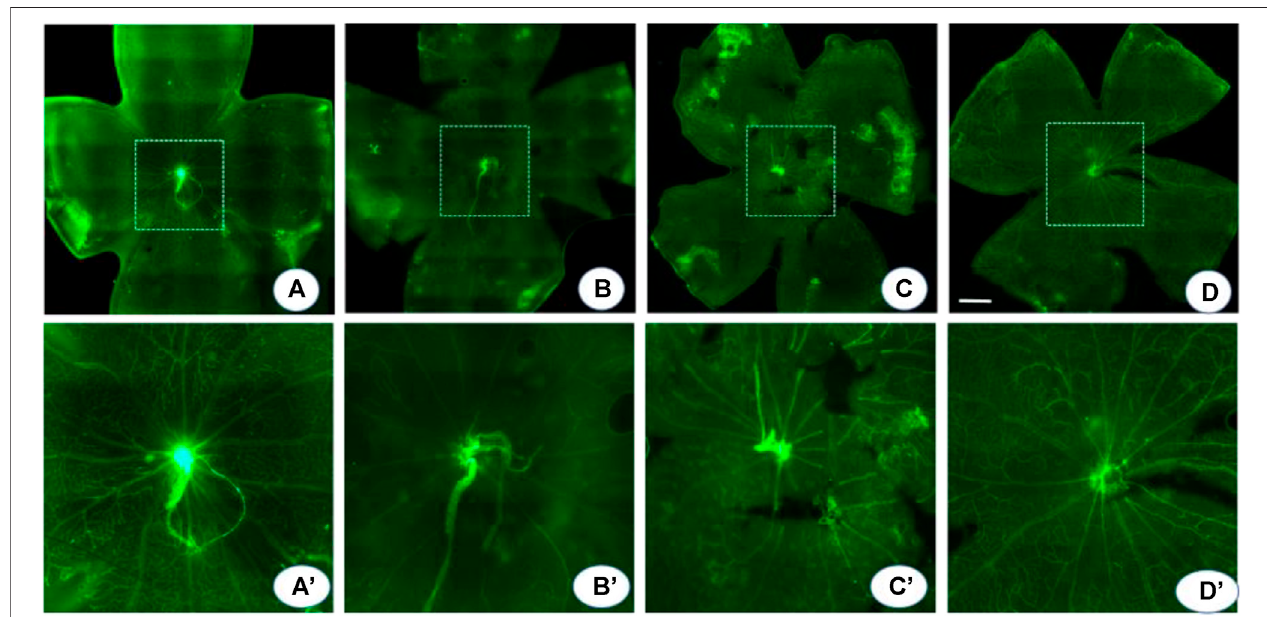
FIGURE4| Probeneciddecreasedcentralvaso-obliteration.Anisolectin fl uorescein – stainedretinal fl atmountwasusedtodetectthecentralvaso-obliteratedarea. (A) Inthenormoxiagroup,theretinalbloodvesselsarearrangedradiallywiththeopticdiscasthecenter,andthequadrantsareevenlyandsymmetricallydistributed.The blood vessels run naturally without any disorder or twist. (B, C) OIR and dH 2 O-treated controls show a vaso-obliteration area in the posterior pole with clump-shaped capillary leakage. In the border zone, the large branch of the blood vessel becomes thin and tortuous. The distorted small branch blood vessel is twisted and clumped. There is extensive neovascularization in the whole retina, local vasodilation, and fl uorescein in fi ltration. (D) Probenecid partially alleviated these pathological changes. (A 9 -D 9 ) are montagesof the (A-D) central area in dash. p < 0.05 (normoxia vs OIR, normoxia vs OIR +dH 2 O, and OIRvs OIR+ probenecid), one-way ANOVA with Tukey ’ s post hoc test. Scale bar: 500 μ m.